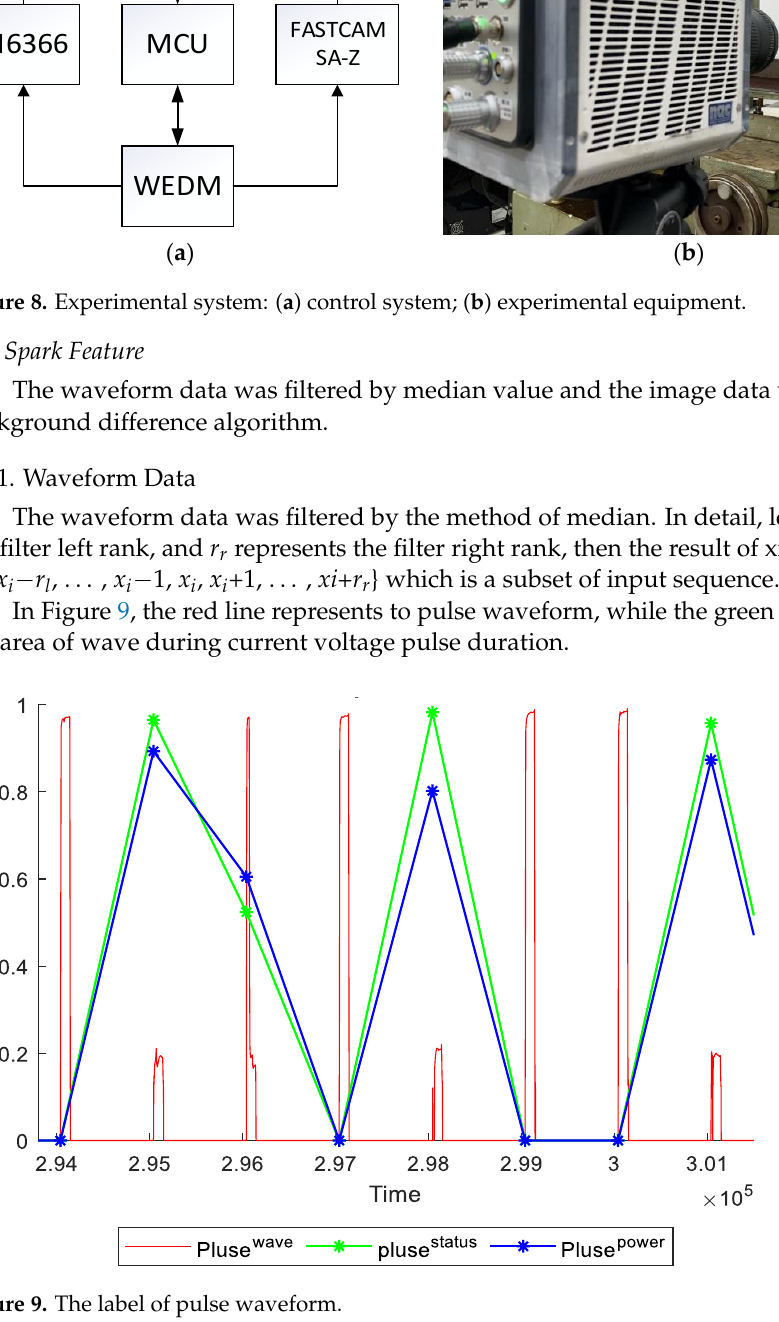
Figure 7. Software trigger timing: ( a ) camera timing; ( b ) acquisition and control timing.